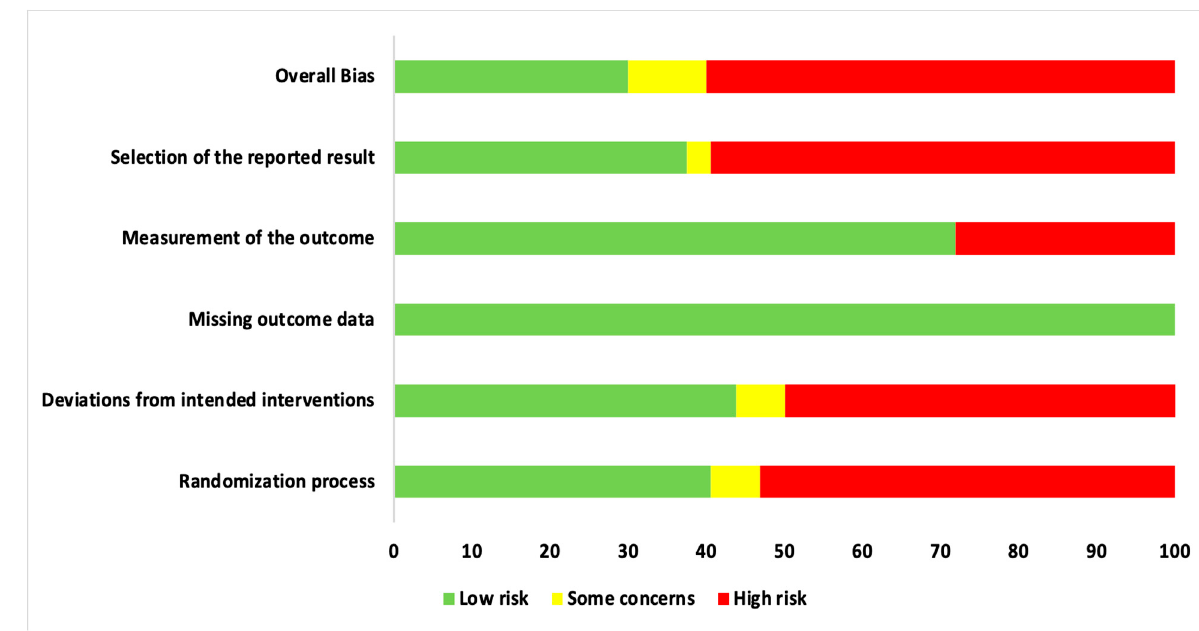
Figure 5. Risk of Bias assessment graph of the included studies expressed as percentages, based on the consensual answers across two individual assessors (S.D. and R.H.).